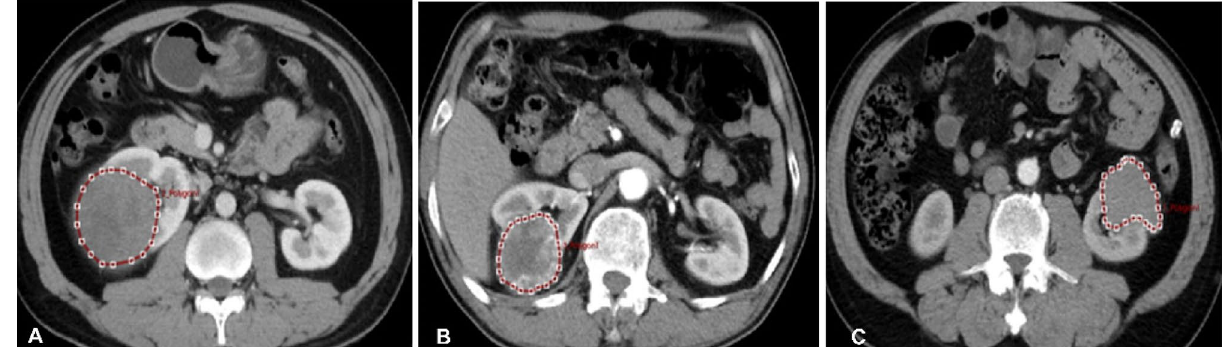
Figure 3. Renal cell carcinoma. ( A ) A 59-year-old man had cortical phase of papillary renal cell carcinoma (RCC) on computed tomography (CT) enhancement (ROI with dotted line). ( B ) A 62-year-old woman had cortical phase of clear cell RCC on CT enhancement (ROI with dotted line). ( C ) A 71-year-old man had cortical phase of chromophobe RCC on CT enhancement (ROI with dotted